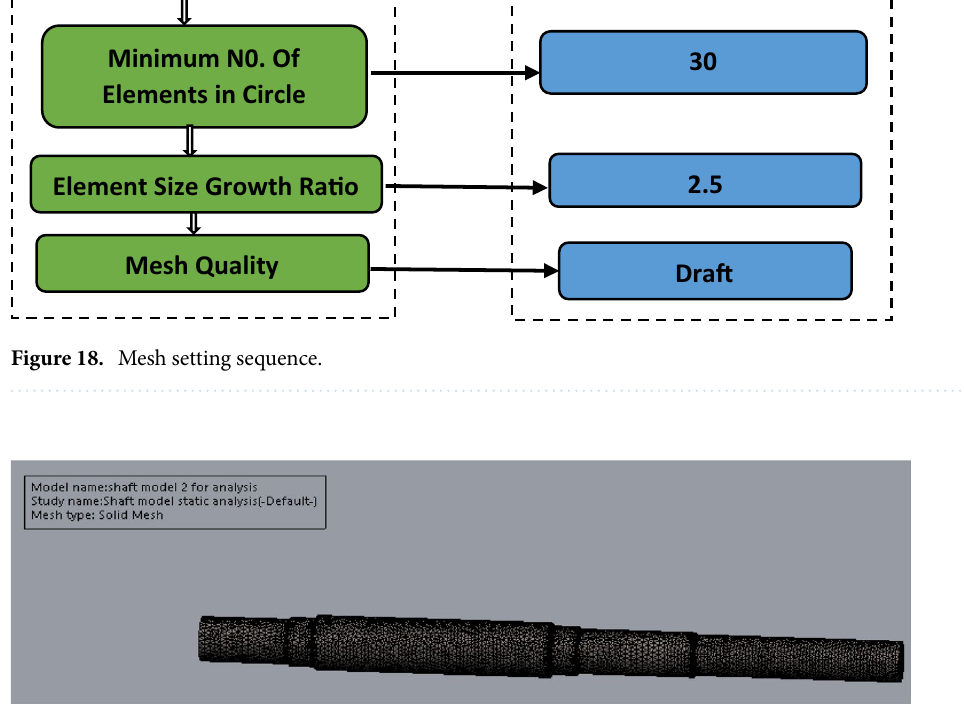
Figure 19. Meshed model of the head